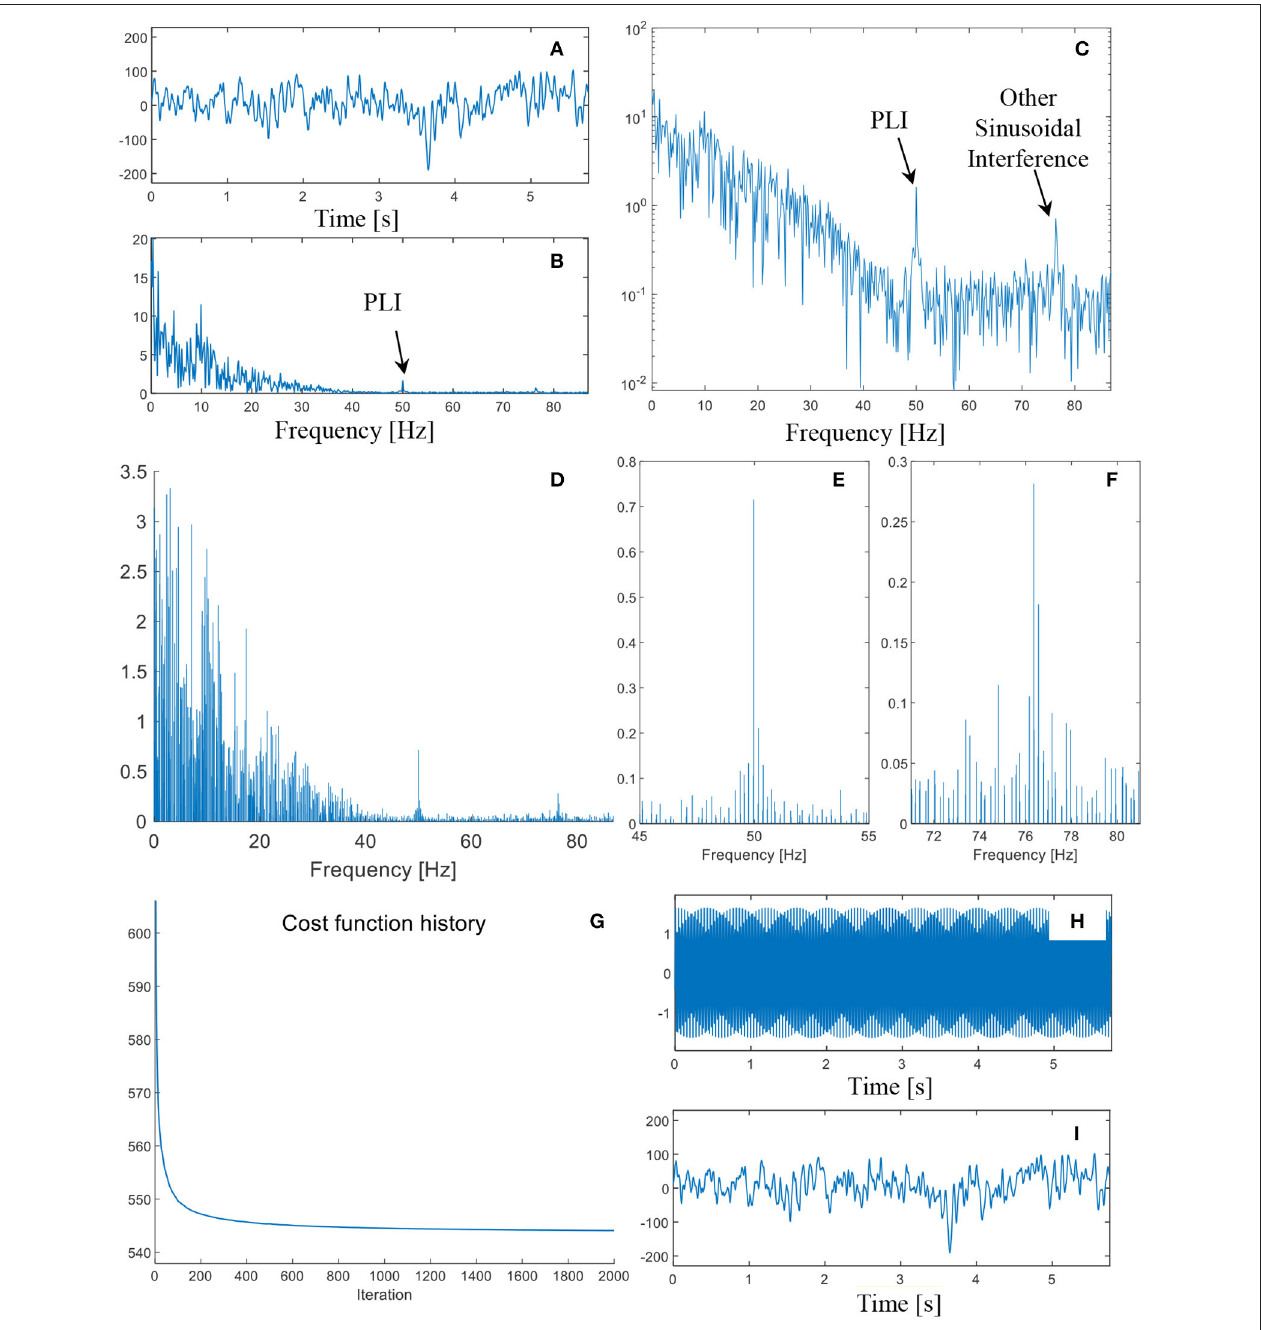
FIGURE 4 | (A) The time domain waveform of the EEG measurement; (B) FFT spectrum in linear scale; (C) FFT spectrum in logarithmic scale; (D) sparse FFT spectrum by the proposed method; (E) zoom-in plot of the sparse spectrum in the neighbor of 50Hz; (F) zoom-in plot of the sparse spectrum in the neighbor of 76Hz; (G) the cost function history of the iterated algorithm; (H) the synthesized compensation signal; and (I) the denoised signal.